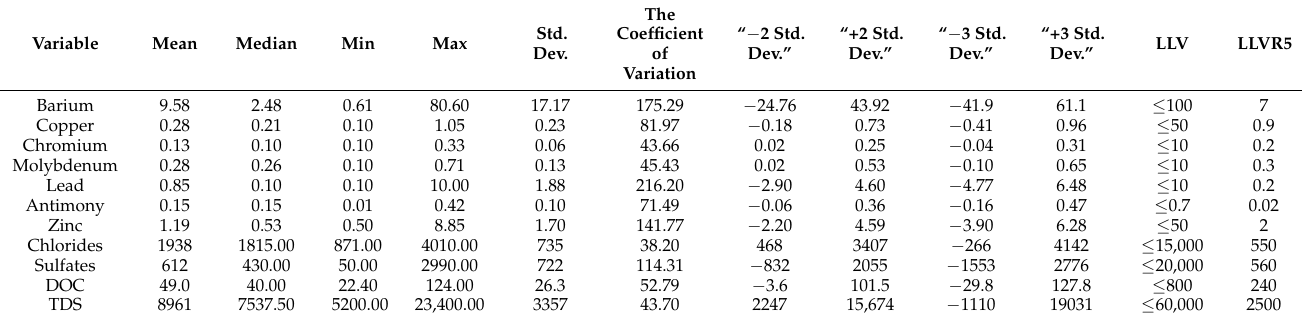
Figure 3. Control charts and trend analysis results for ( a ) SO 42 − , ( b ) DOC, and ( c ) TDS. Table 2. Mean values for the analyzed variables and the values of outliers (2out) and extreme